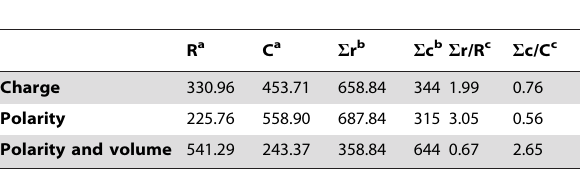
Table 2. Numbers of conservative and radical non- synonymous substitutions on the primate